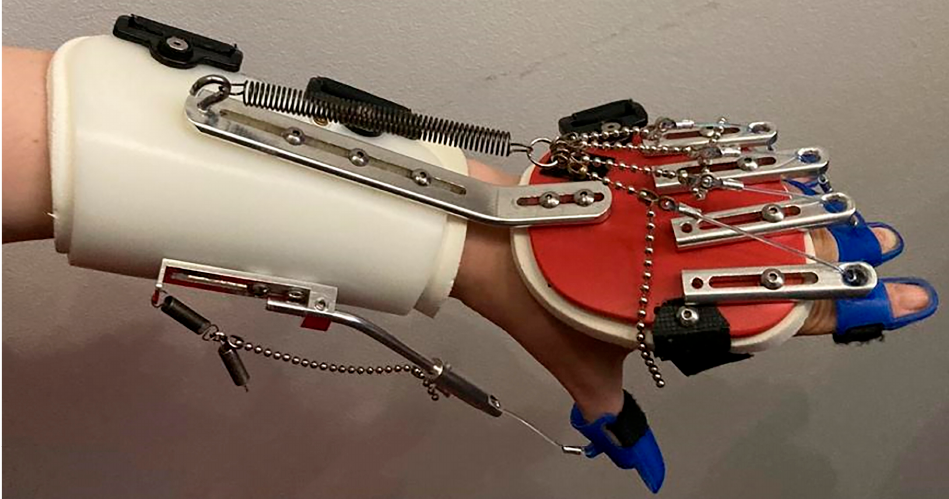
Figure 2. Patient’s upper extremity in the SaeboFlex ® dynamic